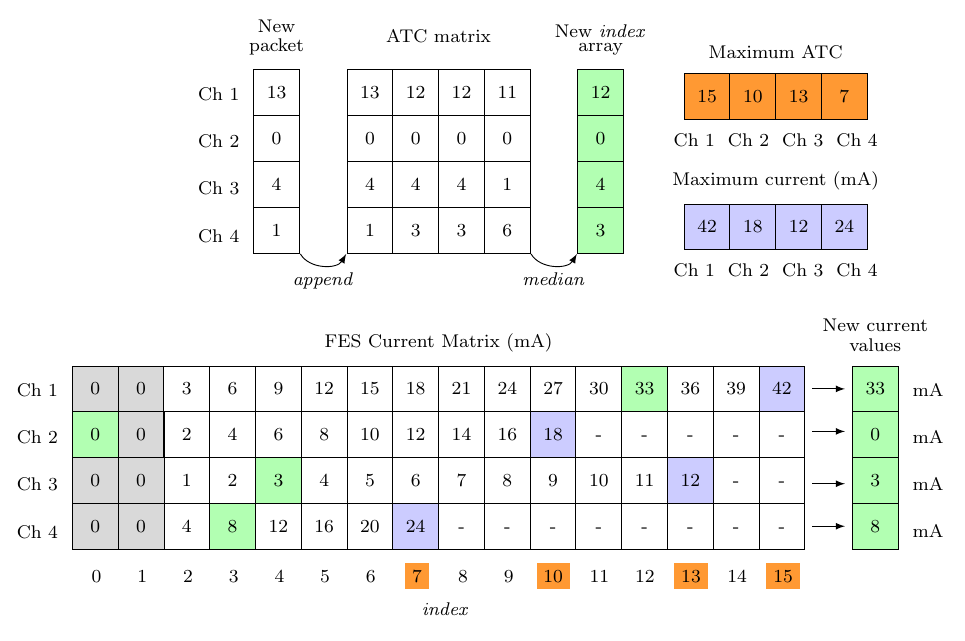
Figure 8. Average Threshold Crossing (ATC)-FES definition process: Green cells represents the links between inputs ATC data and outputs pulses current; orange labels identify the FES current Matrix indexes defined by the Maximal ATC calibration step; blue values correspond to the maximal FES current calibrated with the Current limitation